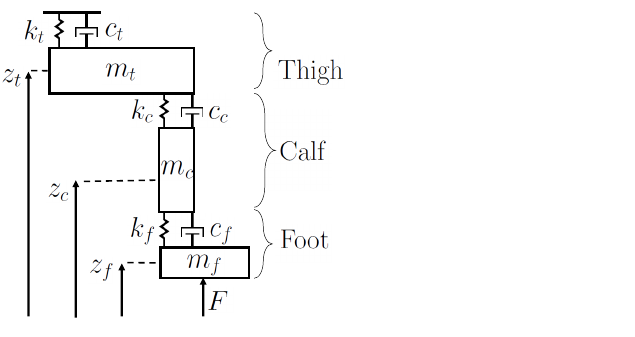
Figure 6. Human lower limb lumped parameter model (adapted from Ref. [43]; data in Table 2).